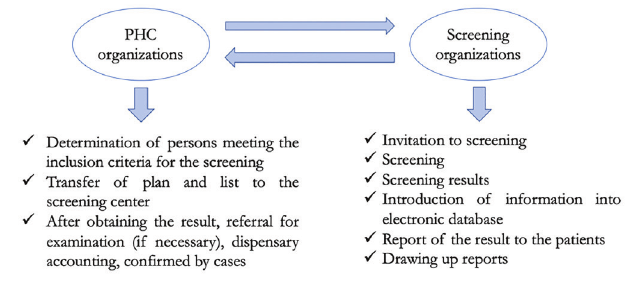
Figure 1 - Algorithm for organizing screenings